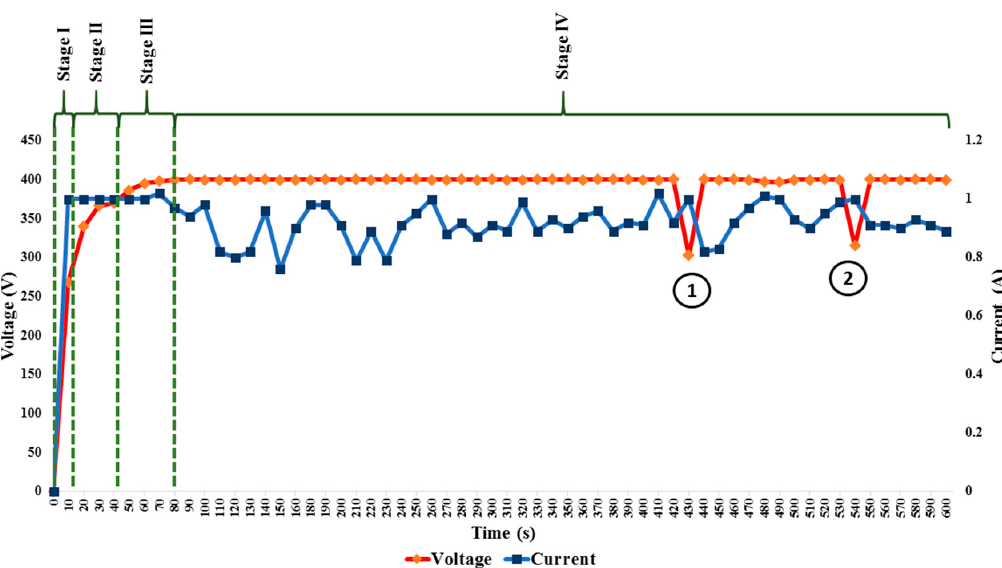
Figure 2. A real-time plot of the voltage and current acquired for 10 minutes of treatment time.